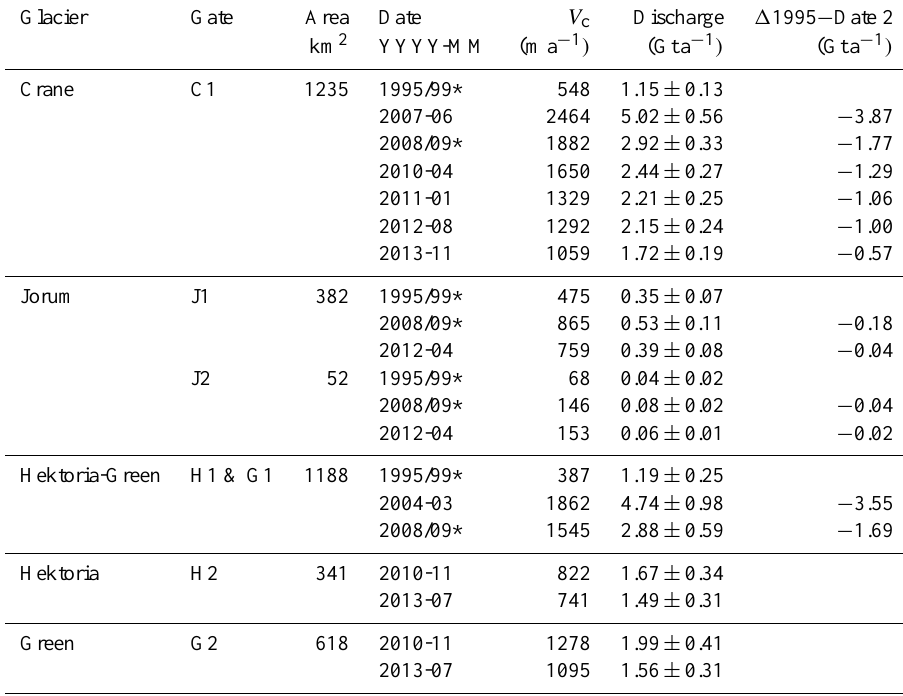
Table 2. Drainage area above the flux gate, velocities at the center of the flux gate ( V c ) , discharge across the flux gates, and difference of discharge vs. 1995; for glaciers draining into Larsen B embayment.